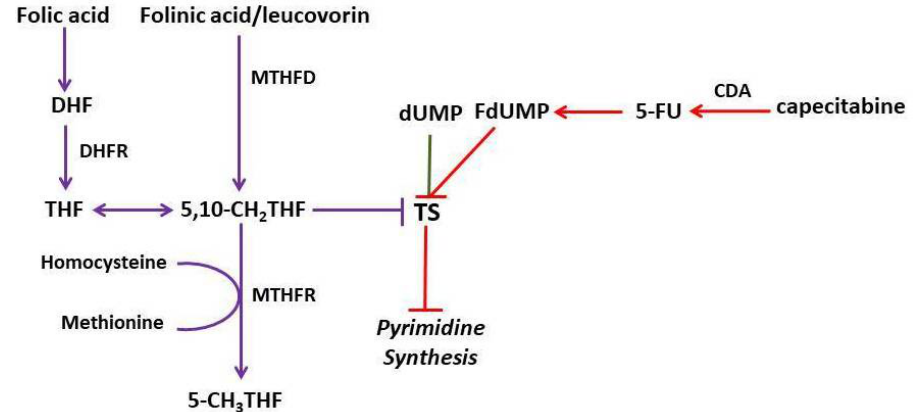
Figure 2. Folate pathway. Abbreviations: DHFR, Diihydrofolate Reductase; THF, Tetrahydrofolate; MTHFD, Methylenetetrahydrofolate dehydrogenase; 5,10-CH2 THF, 5,10-methylenetetrahydrofolate; 5-CH3 THF, 5-Methylenetetrahydrofolate; CDA, Cytidine Deaminase; 5-FU, 5-fluorouracil; dUMP, deoxyuridine monophosphate; TS, Thymidylate synthase; TSER, thymidylate synthase enhancer region; dTMP, deoxythymidine monophosphate (colour figure).